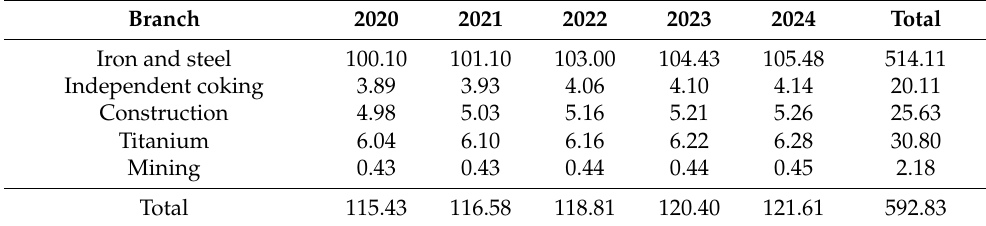
Table 8. Table of energy demand for key industries under pollutant treatment upgrade